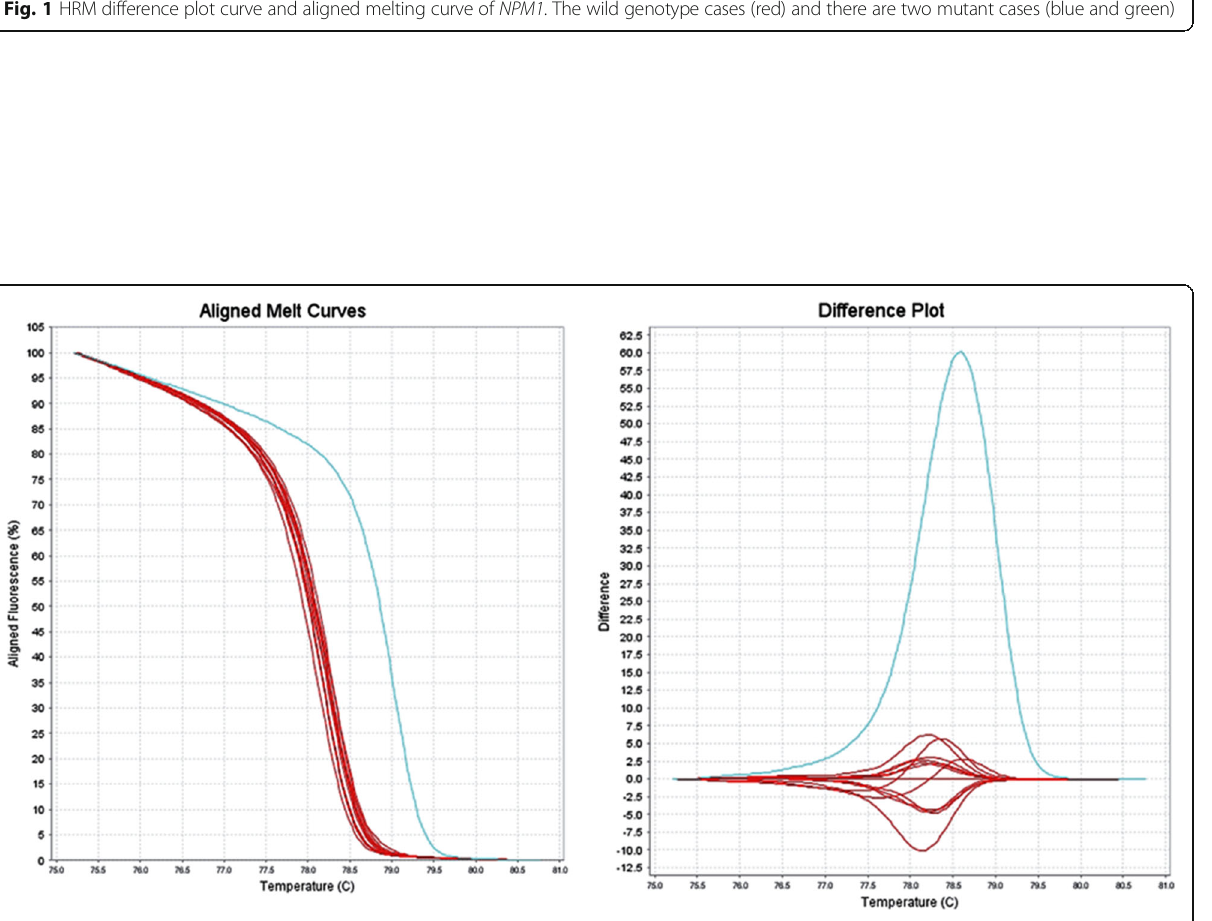
Fig. 2 HRM difference plot curve and aligned melting curve of FLT 3-ITD. The wild genotype (red) and there is one mutant case